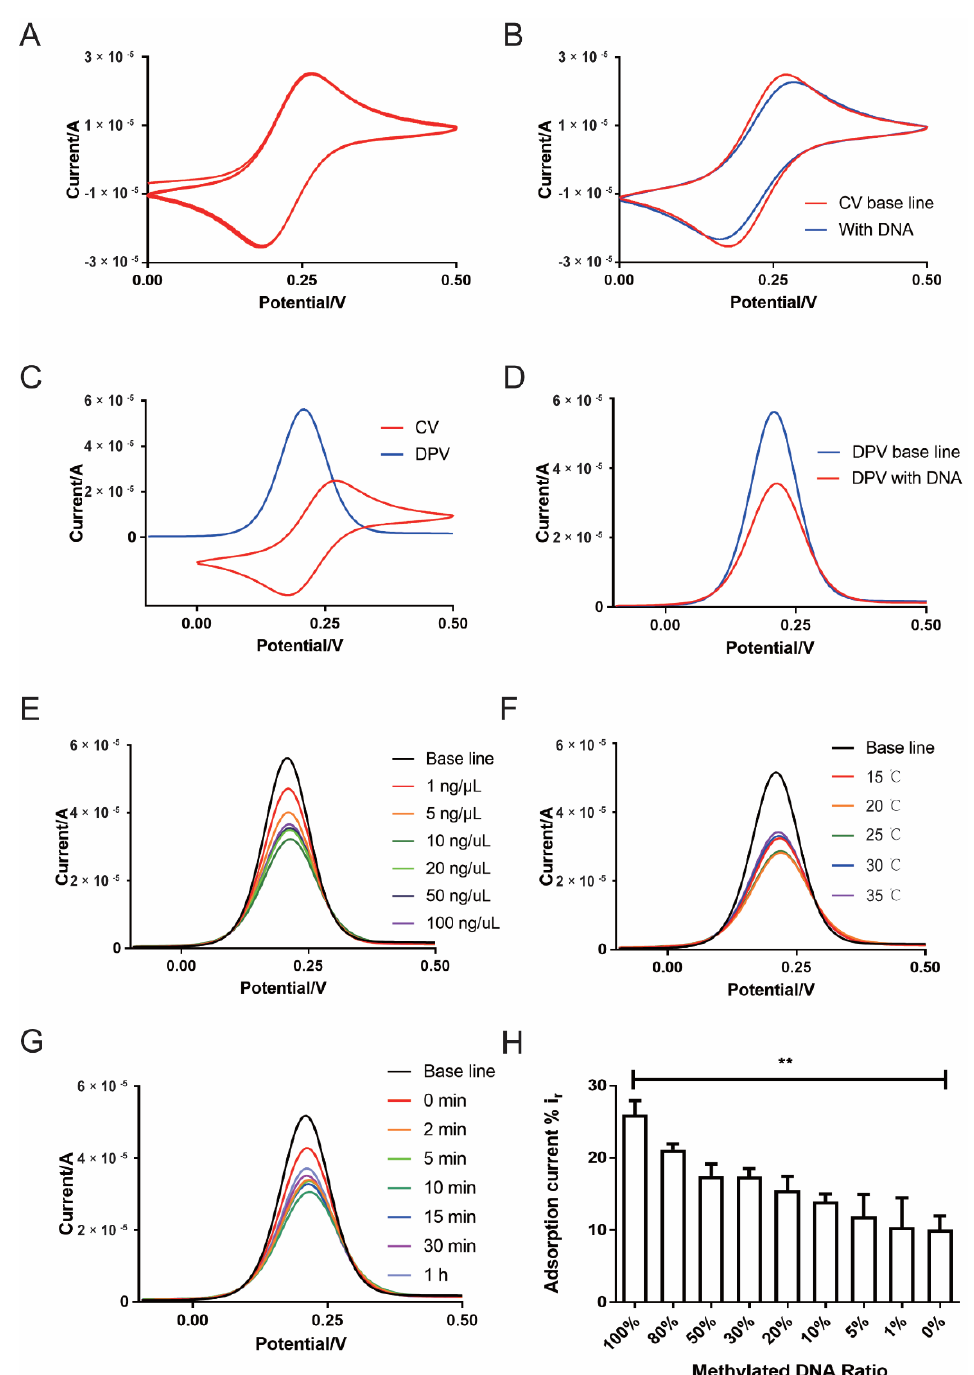
Figure 2. Establishment of an electrochemical detection method and exploration of the optimal detection condition. ( A ) The cyclic voltammetry (CV) curve showed that the system had better stability after the repeated testing of 100 segments. ( B ) The peak current of the CV curve decreased, and the potential difference increased after the adsorption of DNA. ( C ) The range of the differential pulse voltammetry (DPV) peak was determined by the oxidation peak of the CV curve in order to establish a more sensitive detection method. ( D ) The peak current of the DPV curve decreased significantly after DNA was adsorbed. ( E – G ) Optimization of the DNA concentration, the absorption temperature and the incubation time for the highest detection rate. ( H ) The current adsorption rate of methylated DNA in different proportions. ** p < 0.01.